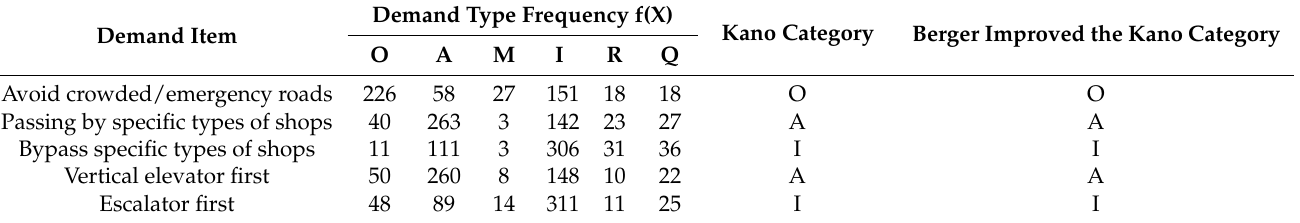
Table 10. Frequency statistics and classification of indoor navigation demand factors in shop- ping